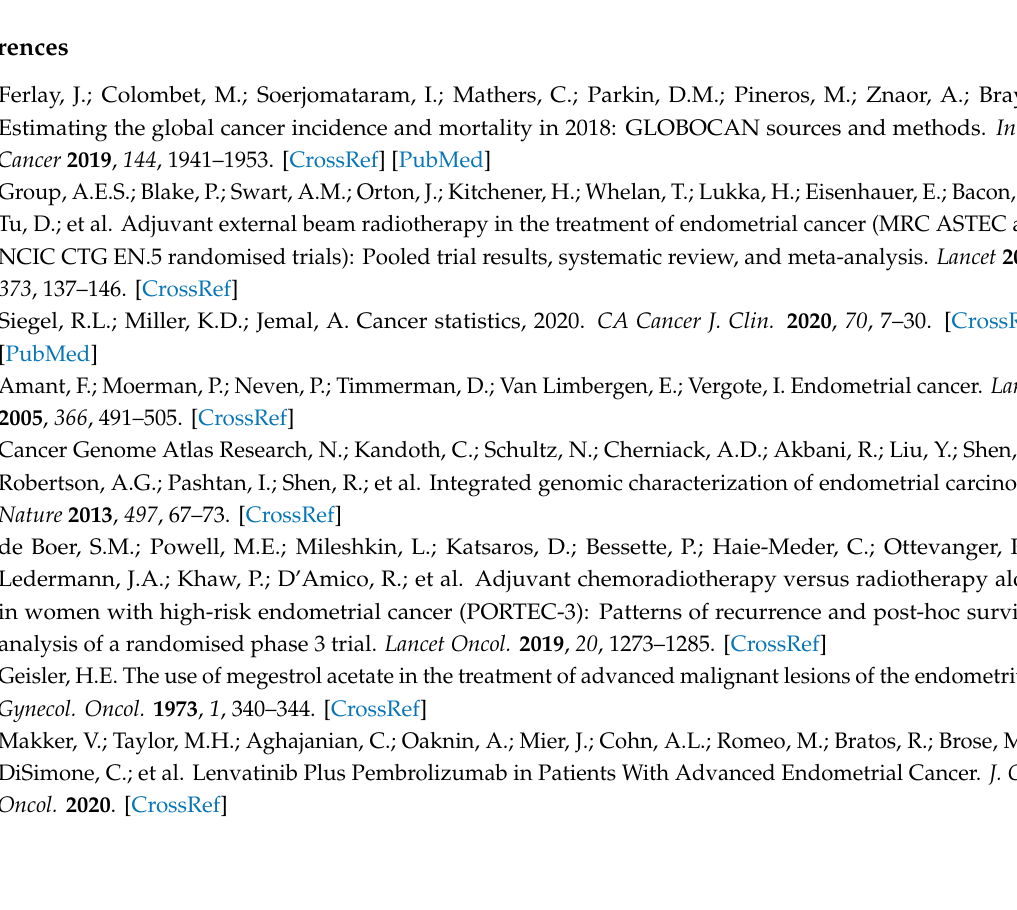
PTEN / PI3K / AKT pathway in endometrial